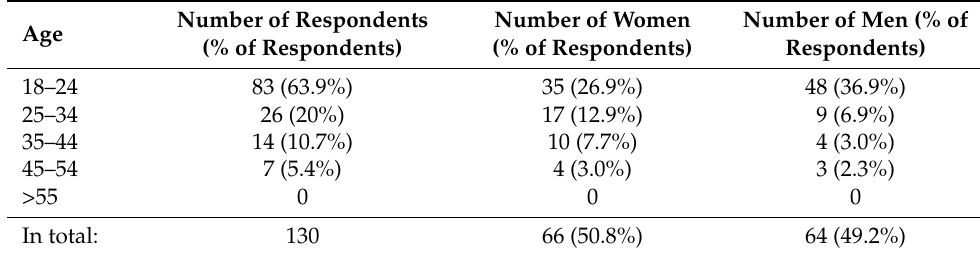
Table 1. Characteristics of the study group.